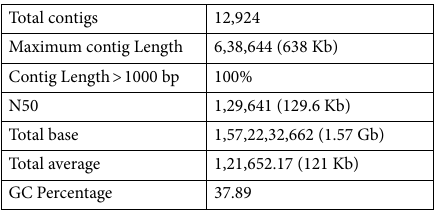
Table 1. Statistics of draft genome assembly of P. kurrooa.